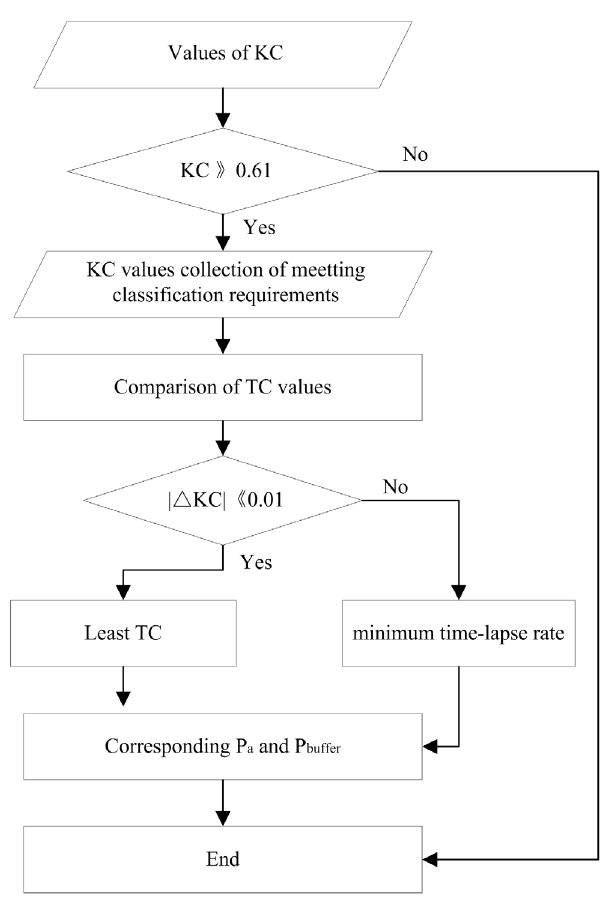
Figure 3. Selection process of portfolio optimisation model (KC: Kappa Coefficient; TC: Time-Consuming).